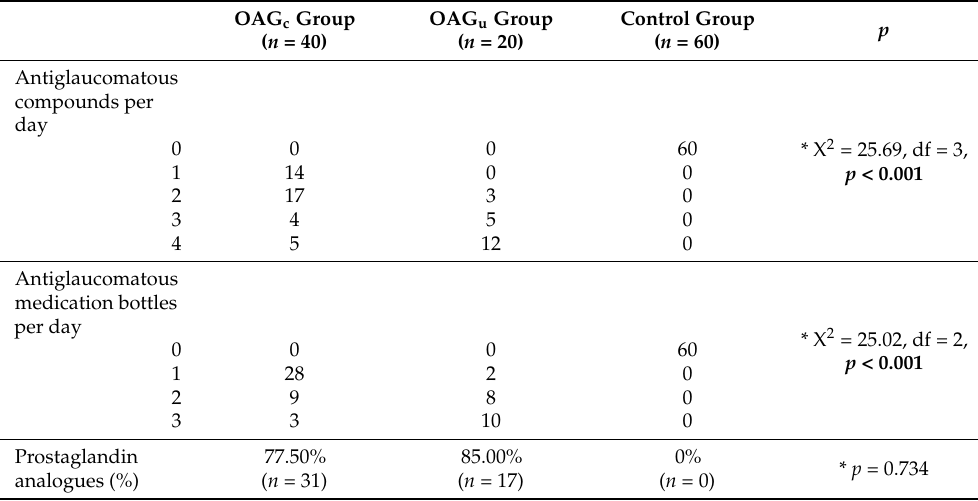
Table 2. Distribution of glaucoma medications in